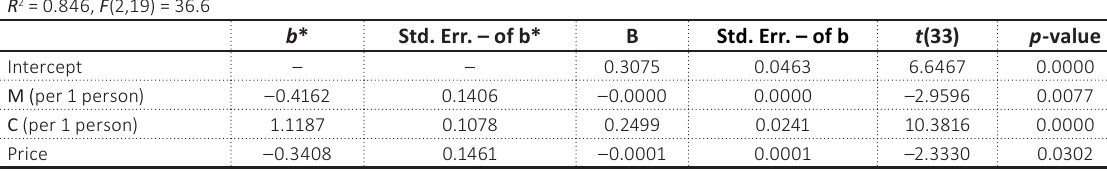
Table 3. The results of multiple linear regression analysis* The results of regression analysis for the dependent variable: A R 2 = 0.846, F (2,19) =